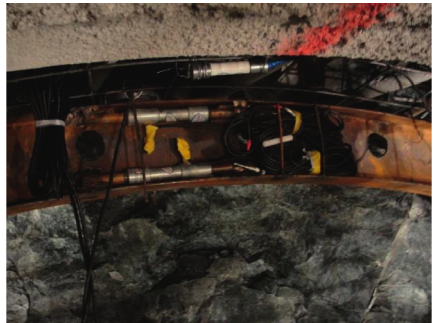
Figure 5: Field measurement of initial support stress.